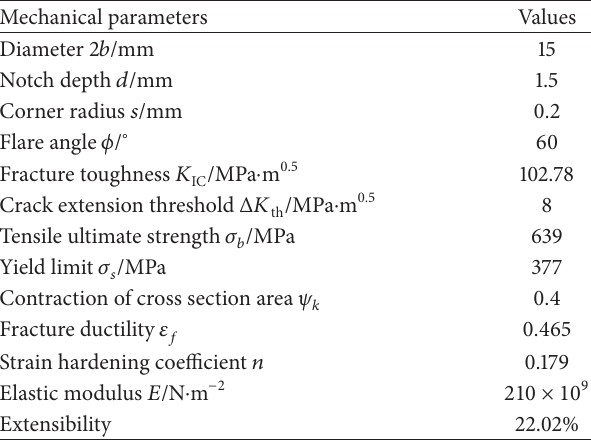
Table 2: Parameters of 45 steel bars. Mechanical